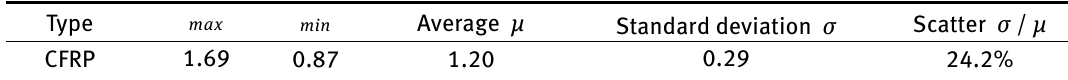
Table 3: Statistical analysis of η for CFRP Type max min Average µ Standard deviation σ Scatter σ / µ CFRP 1.69 0.87 1.20 0.29